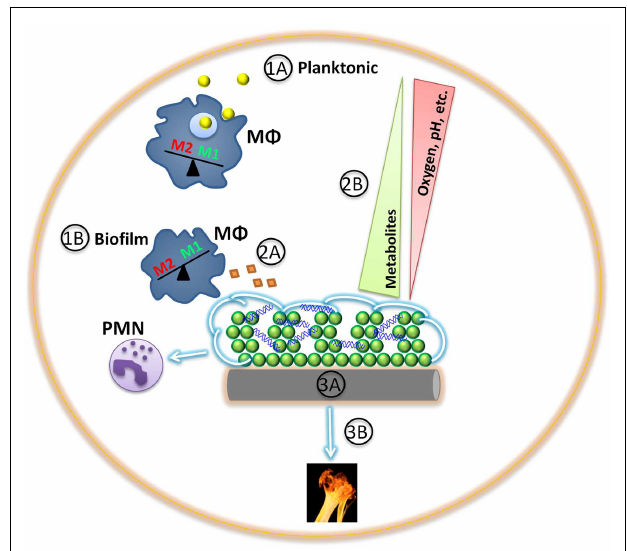
FIGURE 1 | Game of hide-and-seek between staphylococcal biofilms and host innate immunity . (1A) Planktonic staphylococci (yellow) are more readily phagocytosed and cleared by innate immune cells, such as macrophages (M Φ ; blue) and neutrophils (PMNs), triggering a M1 proinflammatory response. (1B) Differential gene expression between planktonic and biofilm staphylococci provide survival benefits in harsh environments, such as the presence of an extracellular matrix (green). In addition, S. aureus biofilms exhibit differential gene expression in response to macrophages or neutrophils (violet), shielding the biofilm from detection by the former while facilitating cytotoxicity of the latter. (2A) Staphylococcal biofilm protein secretion in vivo is relatively unknown and may represent fertile ground for clinical intervention and/or vaccine development. (2B) Staphylococcal biofilms are composed of a large biomass, of which some cells are metabolically active and transform the surrounding microenvironment by establishing various metabolic gradients. (3A) Implanted medical devices (gray) not only provide a scaffold for bacterial adhesion and biofilm formation that is facilitated through host protein deposition (tan), but can also induce a persistent, anti-inflammatory immune response that favors bacterial persistence. (3B) .Tissue damage provoked by staphylococcal nutrient procurement may further incite an overall anti-inflammatory